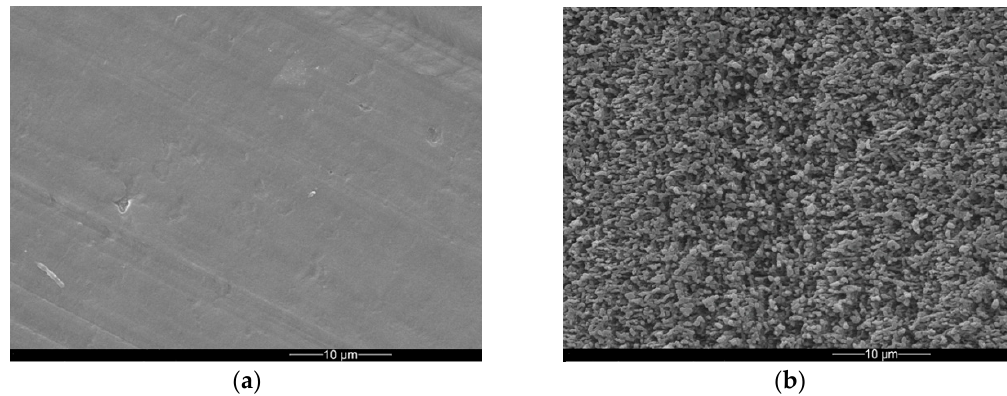
Figure 1. Environmental scanning electron micrograph of a pristine PE surface ( a ) and the corresponding femtosecond laser-processed PE surface ( b ).